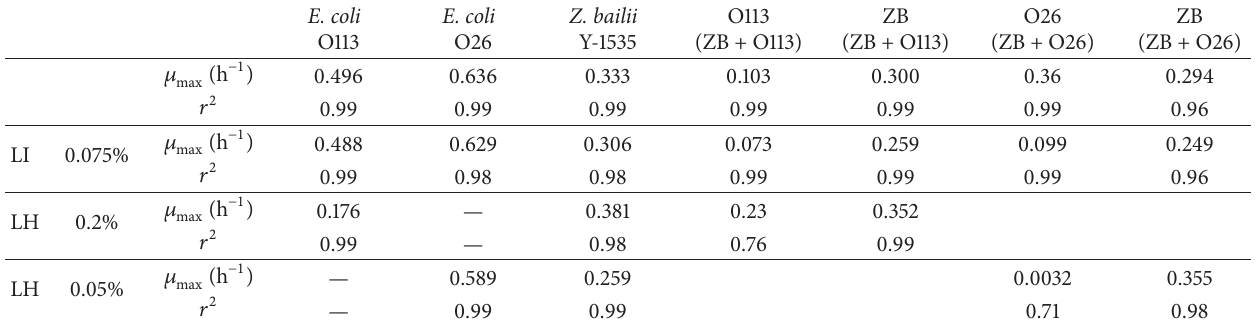
Table 1: Growth parameters of pure and mixed cultures of E. coli 0113, E. coli 026, and Z. bailii Y-1535 grown in YM medium in the presence of the following sanitizer concentrations: 0%, 0.05% LH, 0.2% LH, and 0.075%